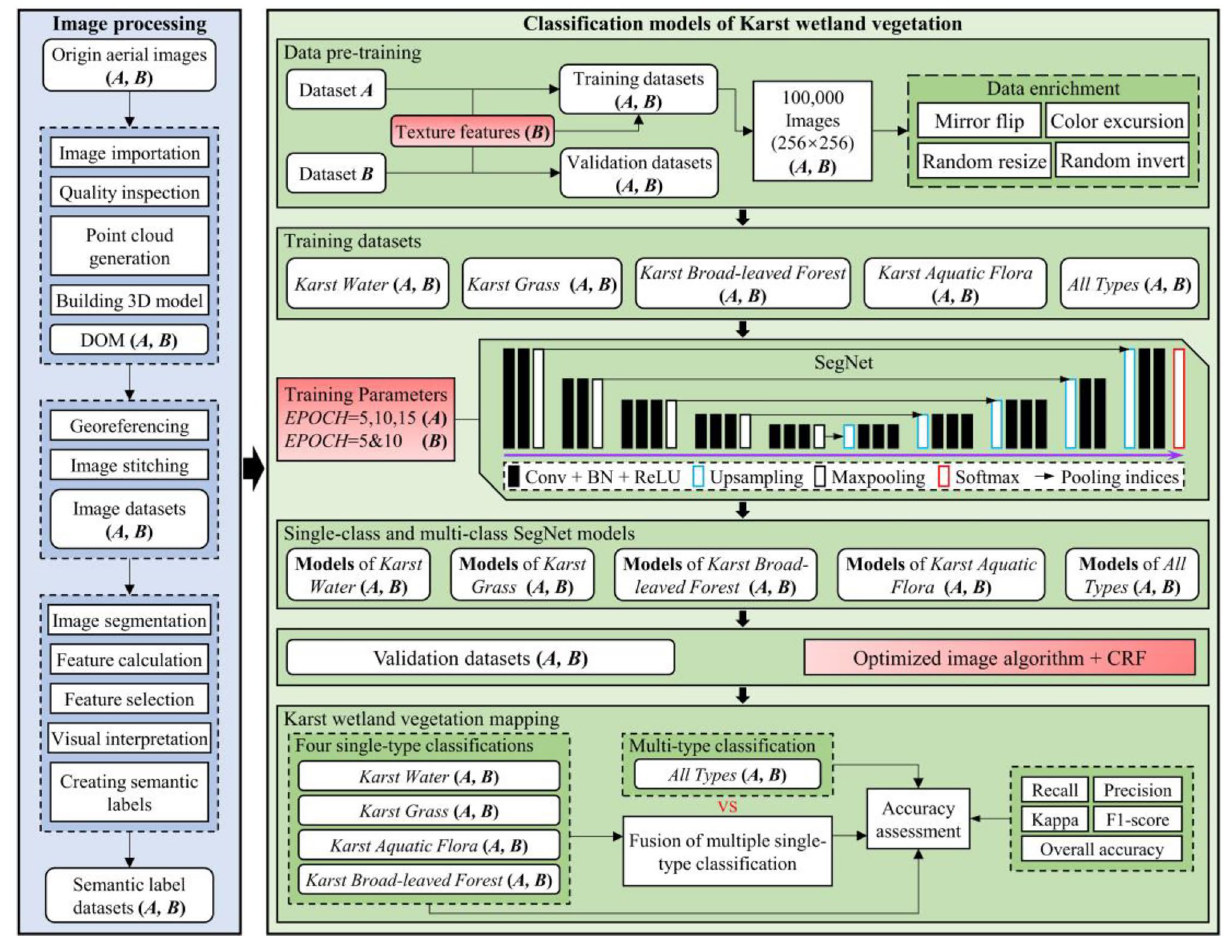
Figure 2. Flowchart of classifying karst wetland vegetation using SegNet